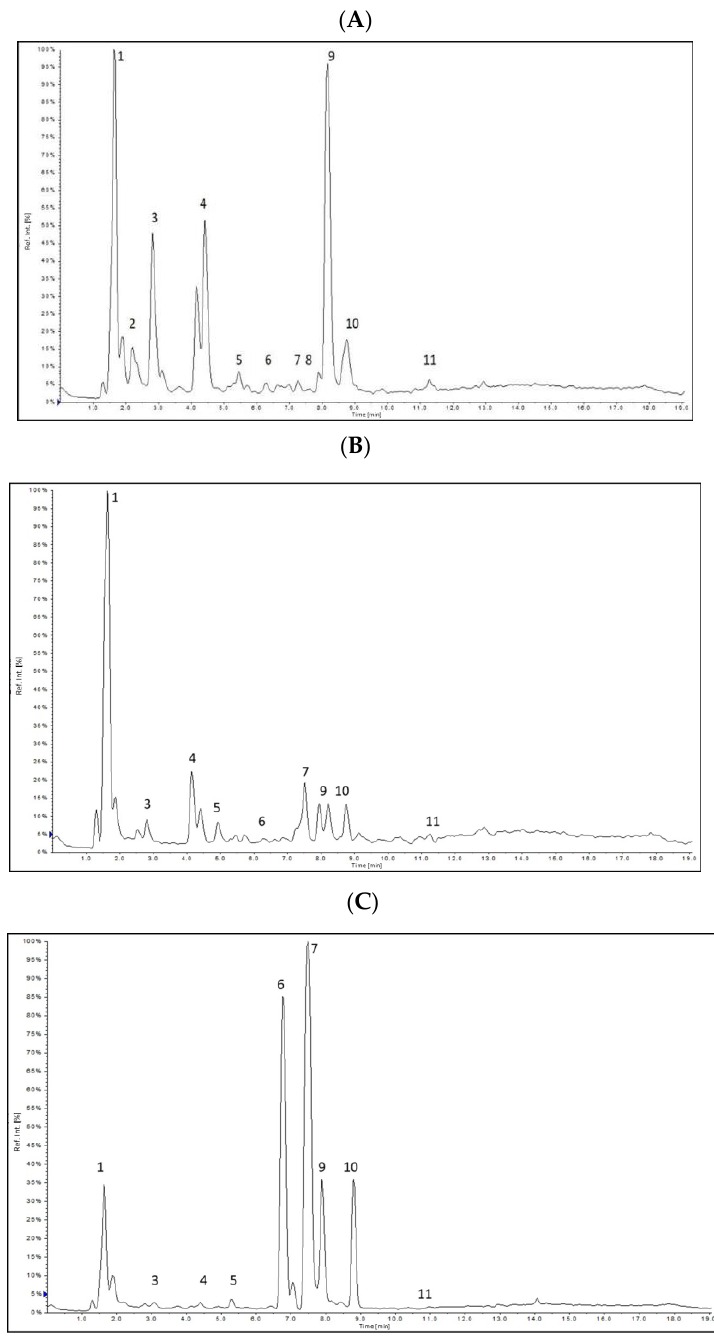
Figure 1. Extracted ion chromatograms (XIC) obtained for ( A ) Epilobium angustifolium L., ( B ) Centella asiatica L., ( C ) Clitoria ternatea L.